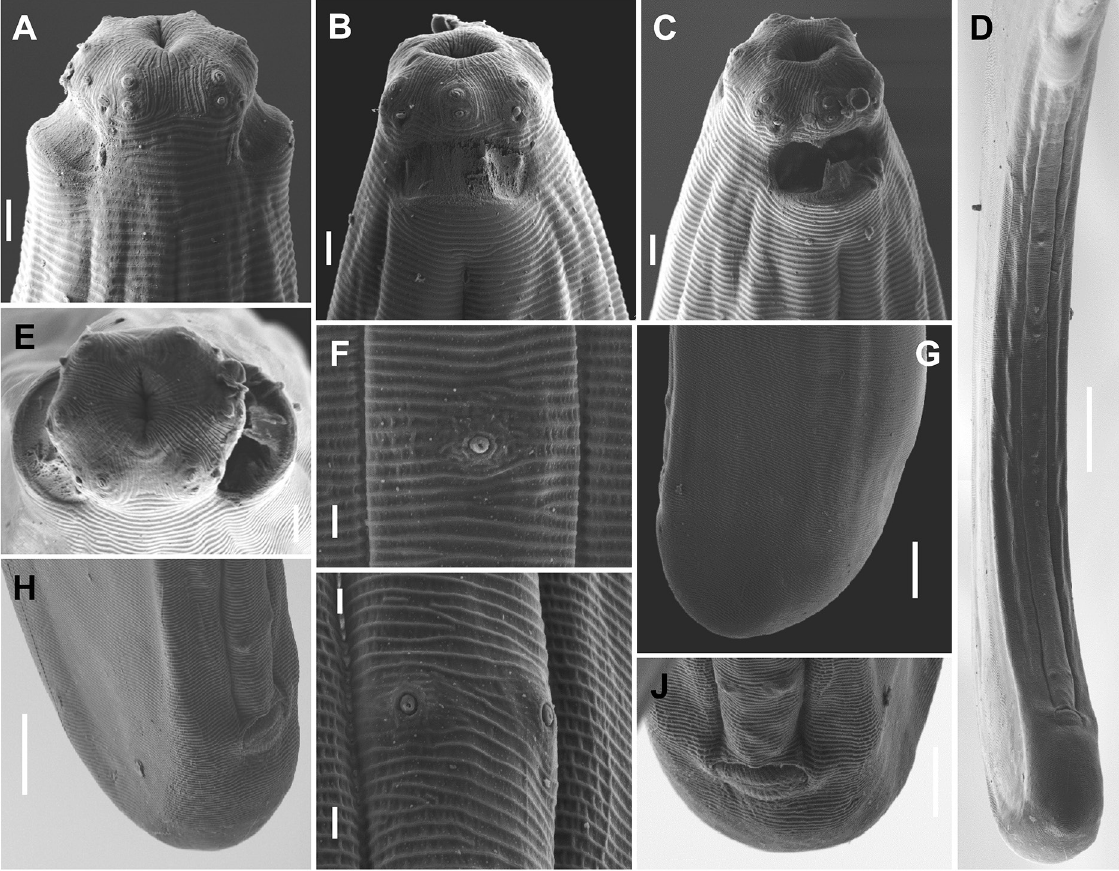
Fig. 9. Sectonema vietnamense sp. nov. (SEM, A = juvenile and B–J = ♂). A . Lip region in ventral view. B – C . Lip region in lateral view. D . Posterior body region in ventral view. E . Lip region in frontal view. F . Detail of a ventromedian supplement. G . Caudal region in lateral view. H . Caudal region in subventral view. I . Detail of the ad-cloacal pair of supplements. J . Caudal region in ventral view.